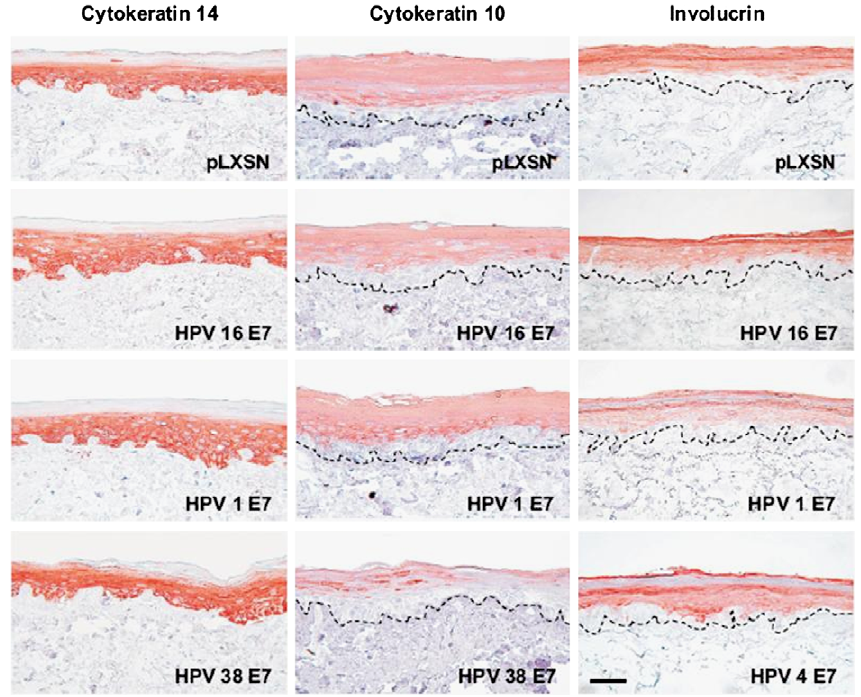
Fig. 3. Perturbed differentiation in HPV 1, HPV 4 and HPV 38 E7 organotypic skin cultures. Paraffin-embedded sections of organotypic skin cultures were stained with antibodies to CK14, CK10 and involucrin. The expression of the basal cell marker CK14 was not altered by any of the HPV types investigated (Suppl. Fig. S3: http://www.qub.ac.uk/isco/JCO). HPV 1, HPV 4 and HPV 38 E7 cultures showed a disturbed expression pattern of either the early (CK10) and/or the late (involucrin) differentiation marker. pLXSN, HPK infected with the control vector. Original magnification was × 400. Scale bar: 100